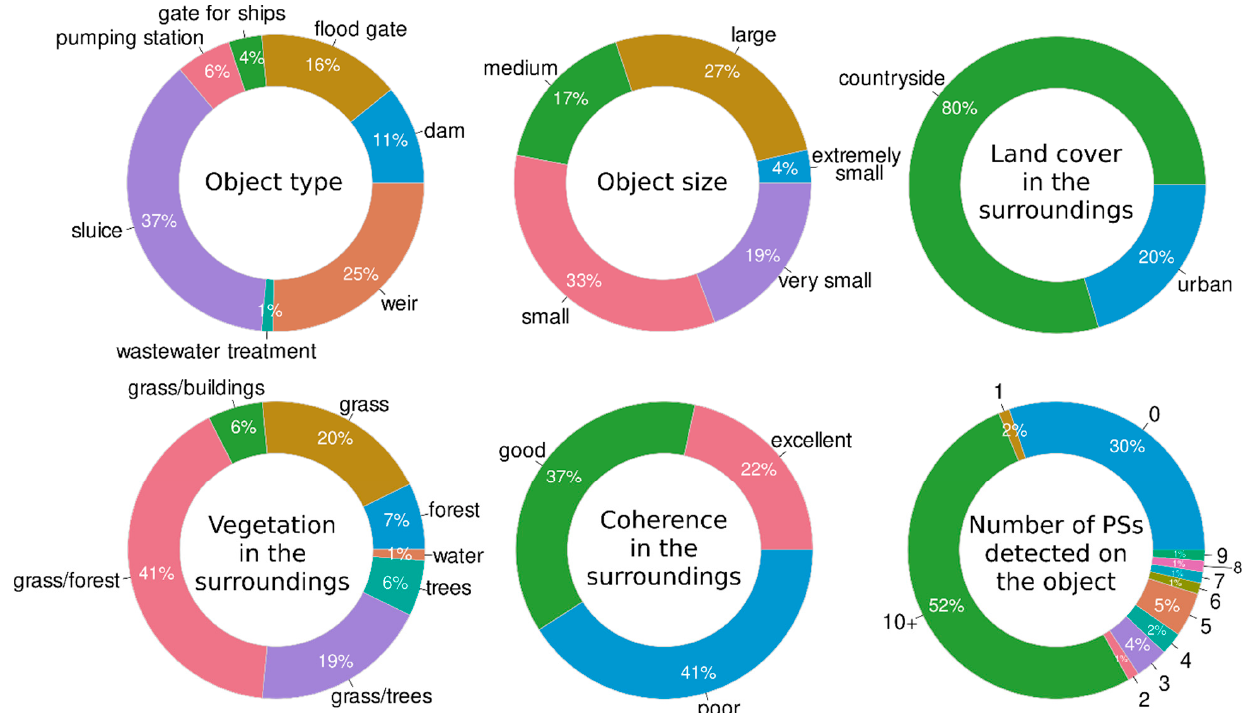
Figure 4. Main features of water management facilities summarized during the preparatory stage. (Object size contains categories extremely small object < 10 m 2 , very small objects < 100 m 2 , 100 m 2 < small objects < 1000 m 2 , 1000 m 2 < medium objects < 10,000 m 2 , and large objects > 10,000 m 2 . Coherence thresholds in the surroundings of facilities were the following: poor < 0.3, 0.3 < good < 0.5, excellent >